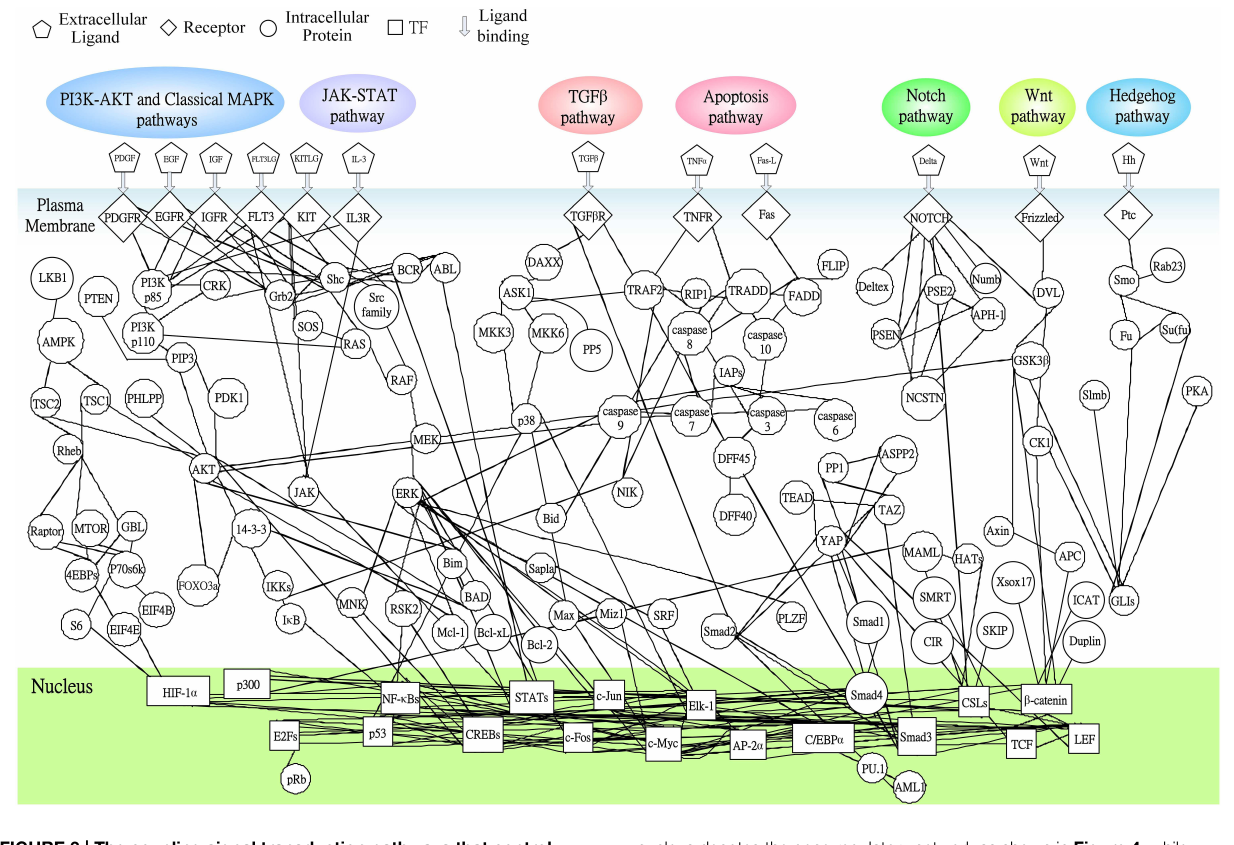
FIGURE 3 | The coupling signal transduction pathways that control gene activities related to leukemogenesis. The figure consists of 147 groups of proteins and 18 groups of TFs. The downstream network in the